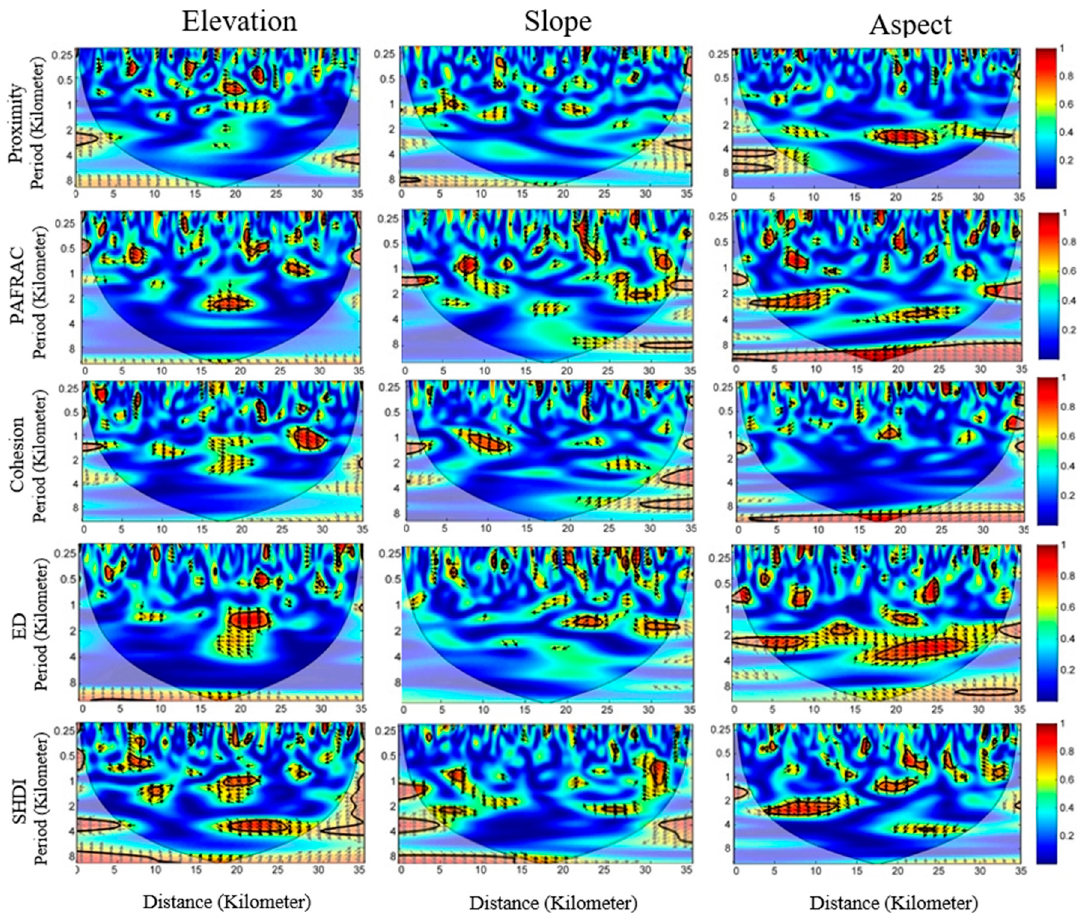
Figure 6. The wavelet coherencies between landscape metrics and topographical factors in profile B.